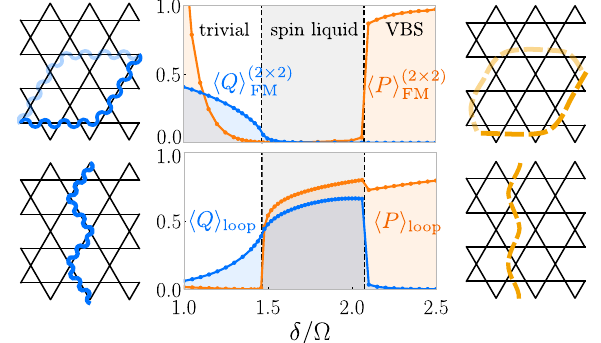
FIG. 6. Diagnosing phases in terms of topological string operators. Top: The Fredenhagen-Marcu (FM) string order parameters show that the trivial phase is an e condensate ( ¼ Higgs phase) and the VBS phase is an m condensate ( ¼ confined phase). These string order parameters decay to zero in the spin liquid, confirming that it is the deconfined phase of the Z 2 lattice gauge theory. We sketch the strings used for calculating the FM order parameter [the transparent strings show the closed loop used to normalize the string; see Fig. 5(c)]. Bottom: Long- range order in the FM string for P ( Q ) suppresses the value of a closed Q ( P ) loop around the circumference. In the spin liquid, both loops are nonzero (we plot the absolute value: Their signs label degenerate ground states; see Fig. 8). As in Fig. 2, results are for XC-8 (depicted) with the vertical (horizontal) direction being periodic